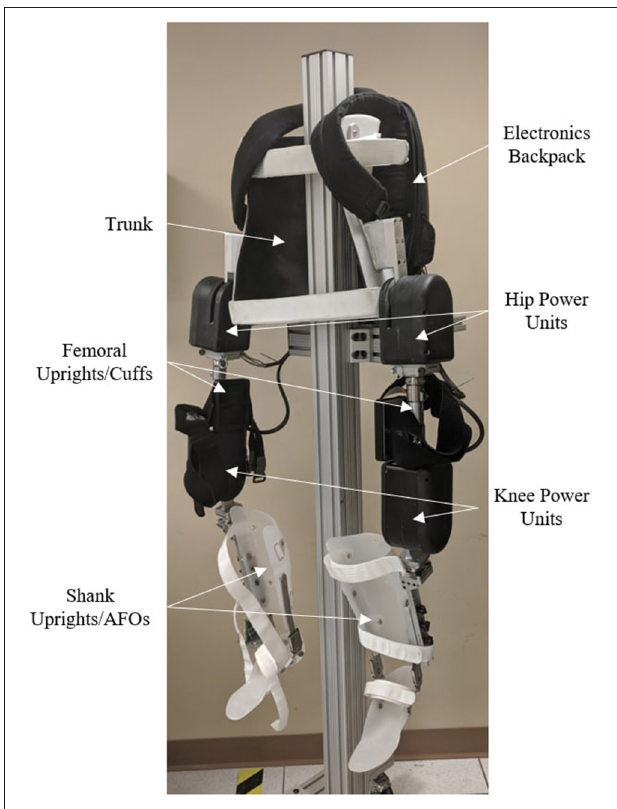
FIGURE 1 | Exoskeleton for the hybrid gait restoration system.